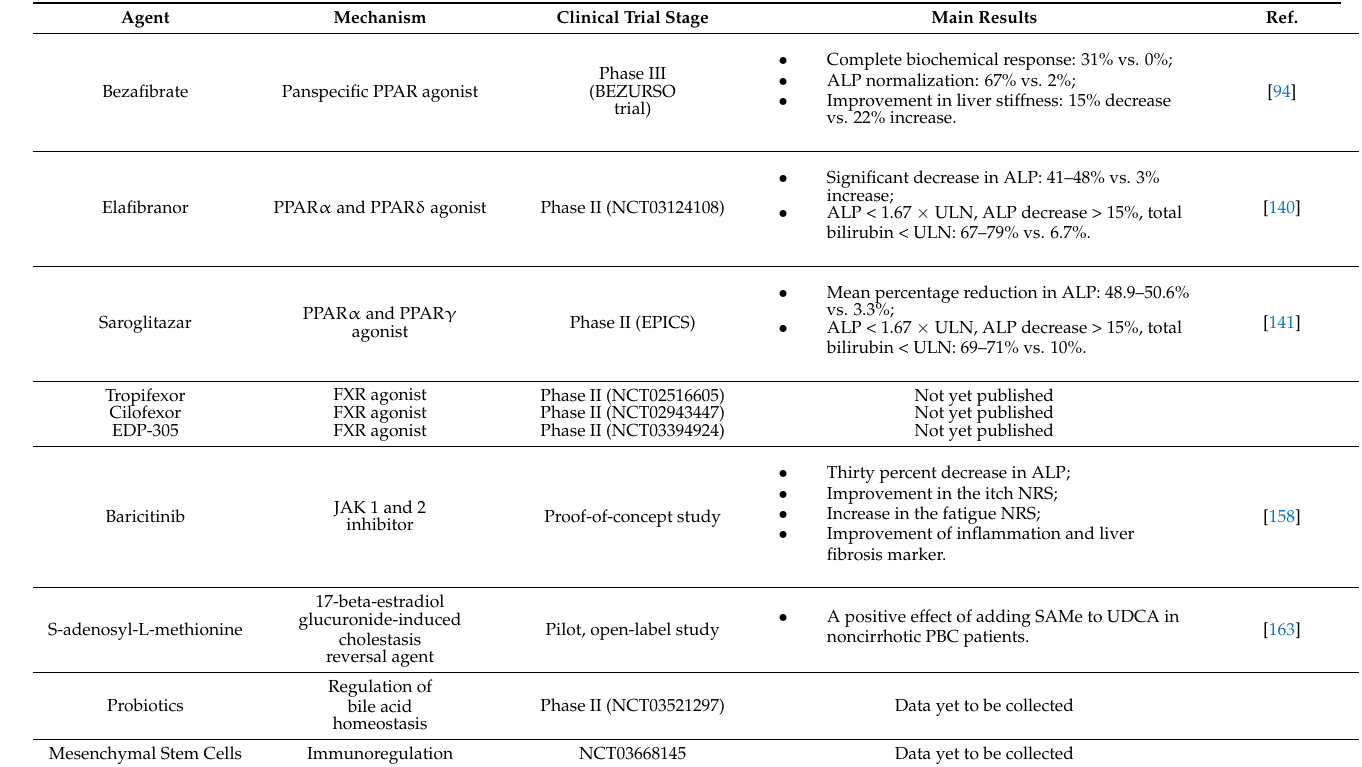
Table 2. Novel therapies currently under investigation in